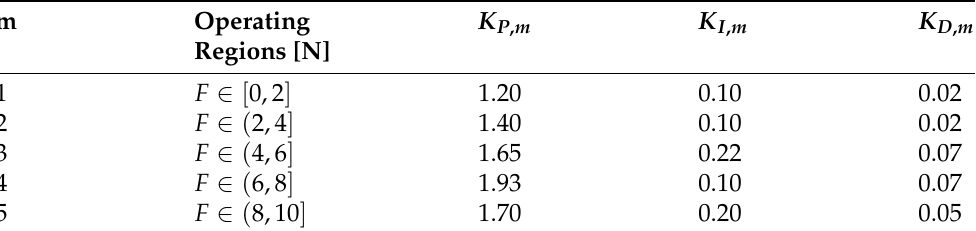
Table 10. PID parameters for the Prototype (B) Closed-Loop control